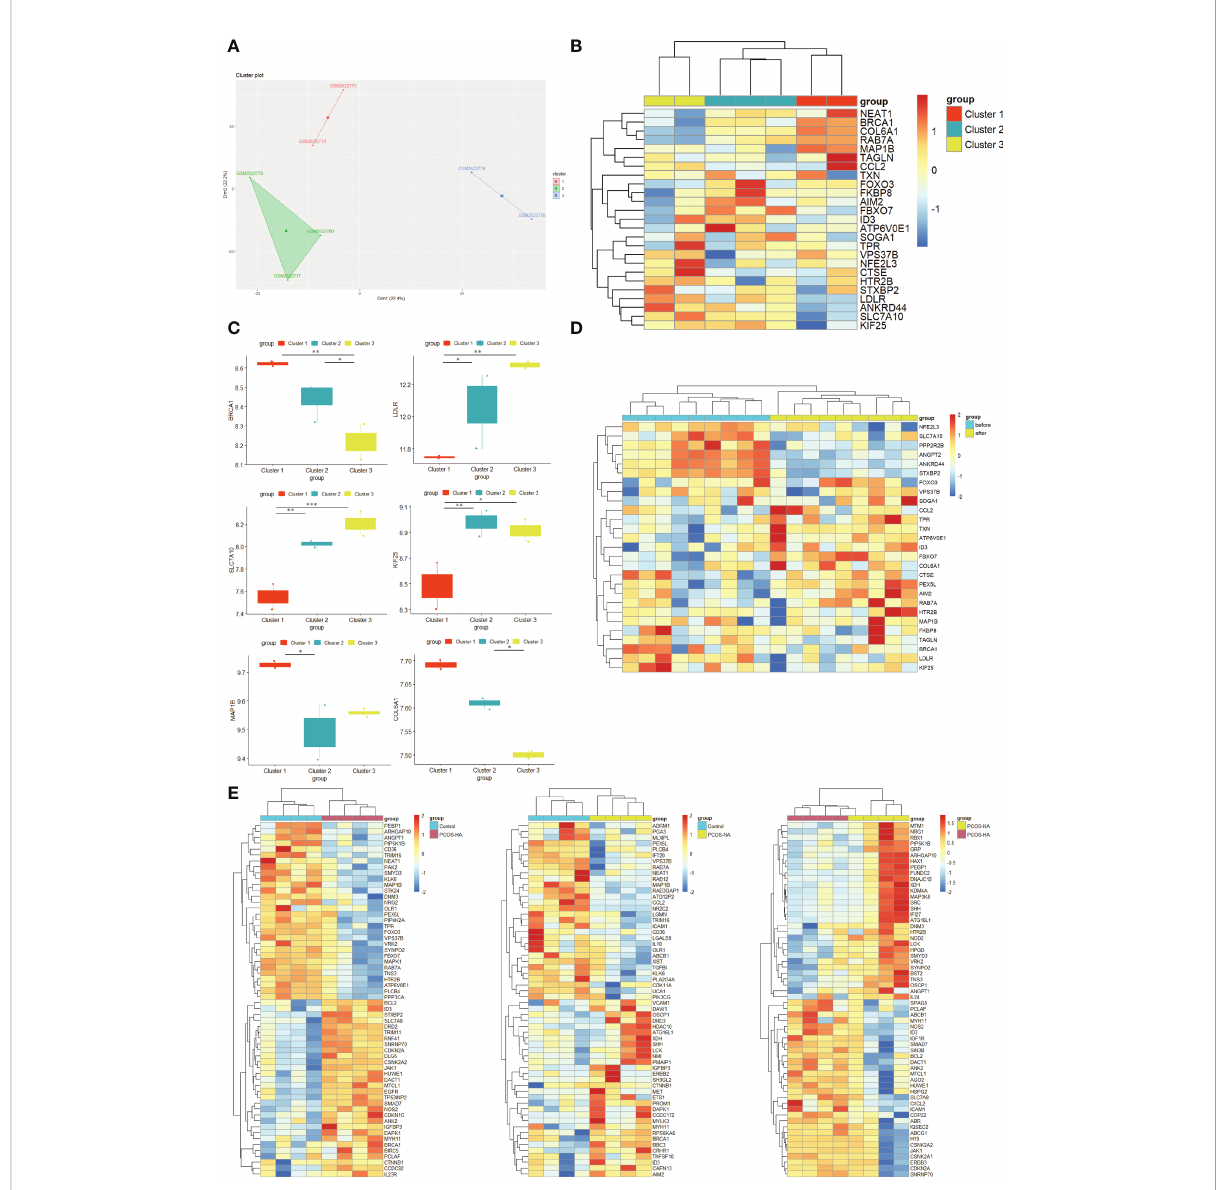
FIGURE 6 New autophagy-related molecular subgroups in PCOS. (A) K-means clustering based on GSE95728. K-means clustering based on SSE to realize the selection of K value (K=3). Tsne diagram shows the clustering of women with PCOS. (B) Heatmap showing the expression of 29 co- expressed hub ATGs in PCOS new molecular subgroups. The columns represent 3 subgroups for patients with PCOS (red, blue and yellow columns). The color represents the expression value (log2(exp+1)). Red rows indicate up-regulation, whereas blue rows indicate down- regulation. The darker the color, the greater the difference. (C) The expression of hub ATGs in different clusters. Box plot showing the mRNA expression of hub ATGs genes in three clusters. p<0.05 was considered statistically signi fi cant. **: p < 0.01, *: p < 0.05. (D) Heatmap showing the expression of the ATGs in PCOS insulin sensitizer treatment groups. The columns represent patients with PCOS before (blue columns) and after pioglitazone treatment (yellow columns). The color represents the expression value (log2(exp+1)). Red rows indicate up-regulation, whereas blue rows indicate down-regulation. The darker the color, the greater the difference. (E) Heatmap showing the expression of the ATGs in PCOS-androgen-related subgroups. The columns represent healthy controls (blue columns), PCOS patients with NA(Normal androgen) (yellow columns),and HA(Hyperandrogenism) (red columns). Red rows indicate up-regulation, whereas blue rows indicate down-regulation. The darker the color, the greater the